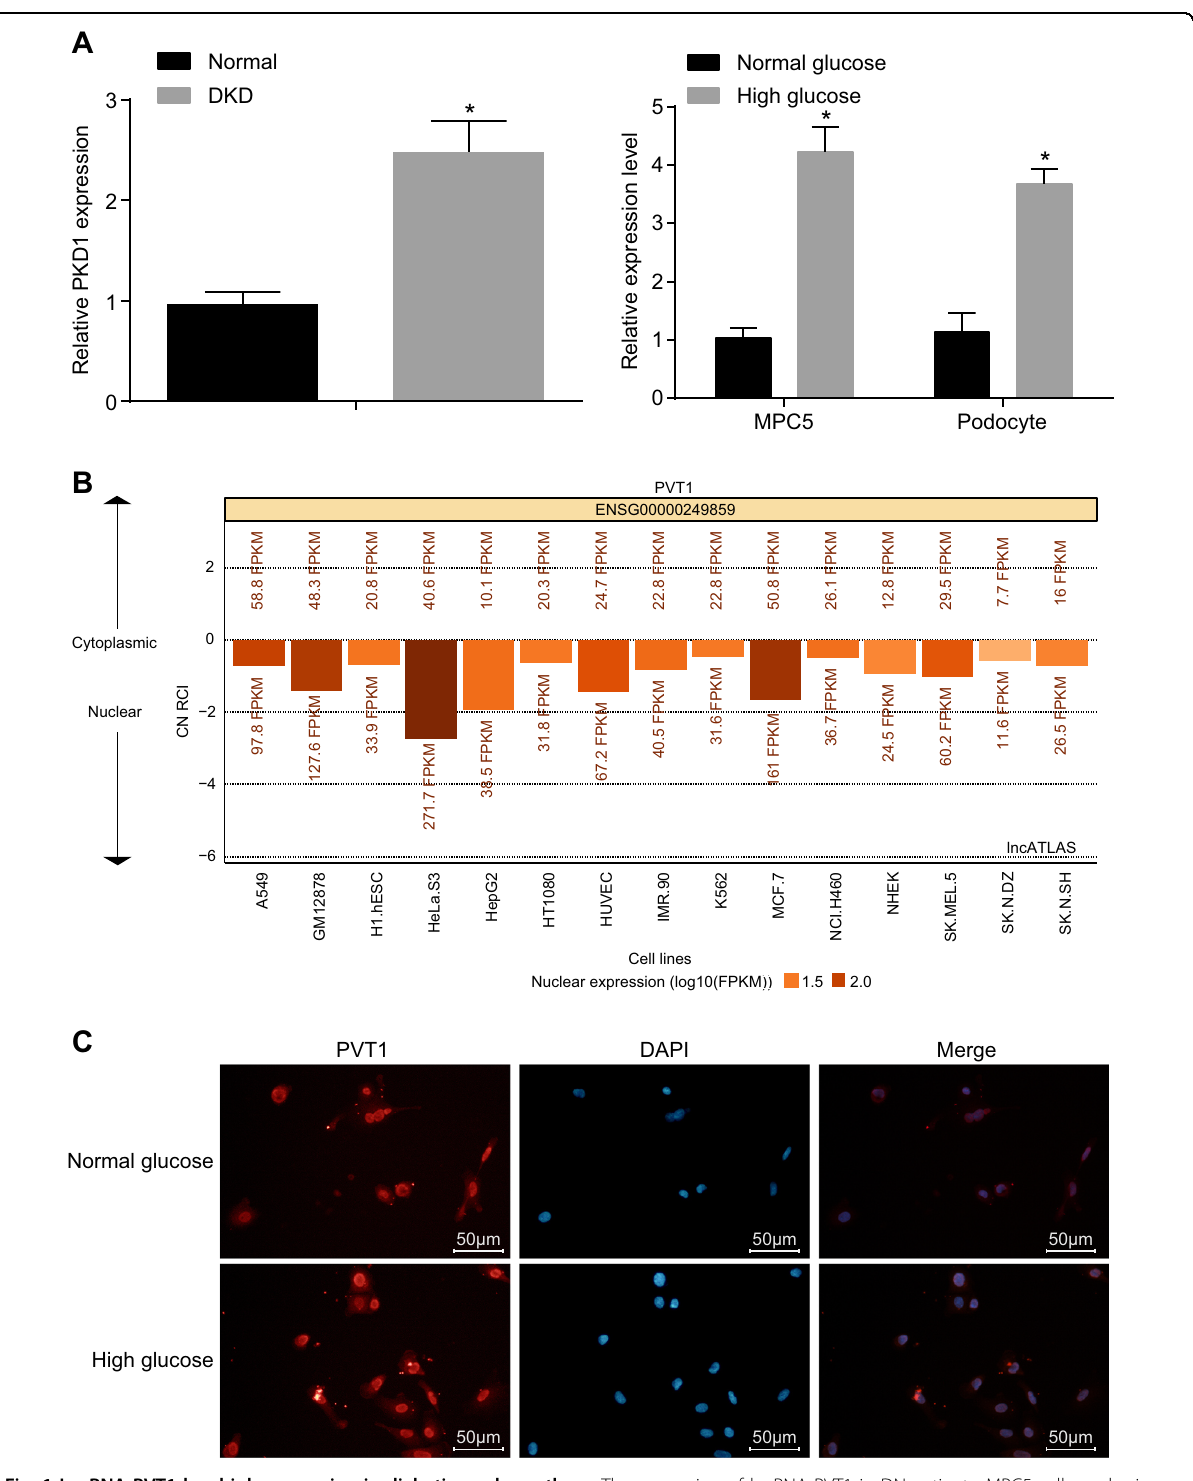
Fig. 1 LncRNA PVT1 has high expression in diabetic nephropathy. a The expression of lncRNA PVT1 in DN patients, MPC5 cells, and primary podocytes in HG medium as determined by RT-qPCR. b , c The subcellular location of lncRNA PVT1 was primarily located in the nucleus, predicted by the lncATLAS website and detected by FISH (the original magni fi cation is ×200); * p < 0.05 vs. the normal control and the NG group, respectively. The measurement data are expressed as the mean ± standard deviation, and the comparisons between the two groups were analyzed by Student ’ s t test. The experiment was repeated three times. DN, diabetic nephropathy; MPC5, mouse podocyte clone 5; NG, normal glucose; HG, high glucose; DAPI, 4 ′ ,6-diamidino-2-phenylindole; PVT1, plasmacytoma variant translocation 1; lncRNA PVT1, long noncoding RNA plasmacytoma variant translocation 1; RT-qPCR, reverse transcription-quantitative polymerase chain reaction; FISH, fl uorescence in situ